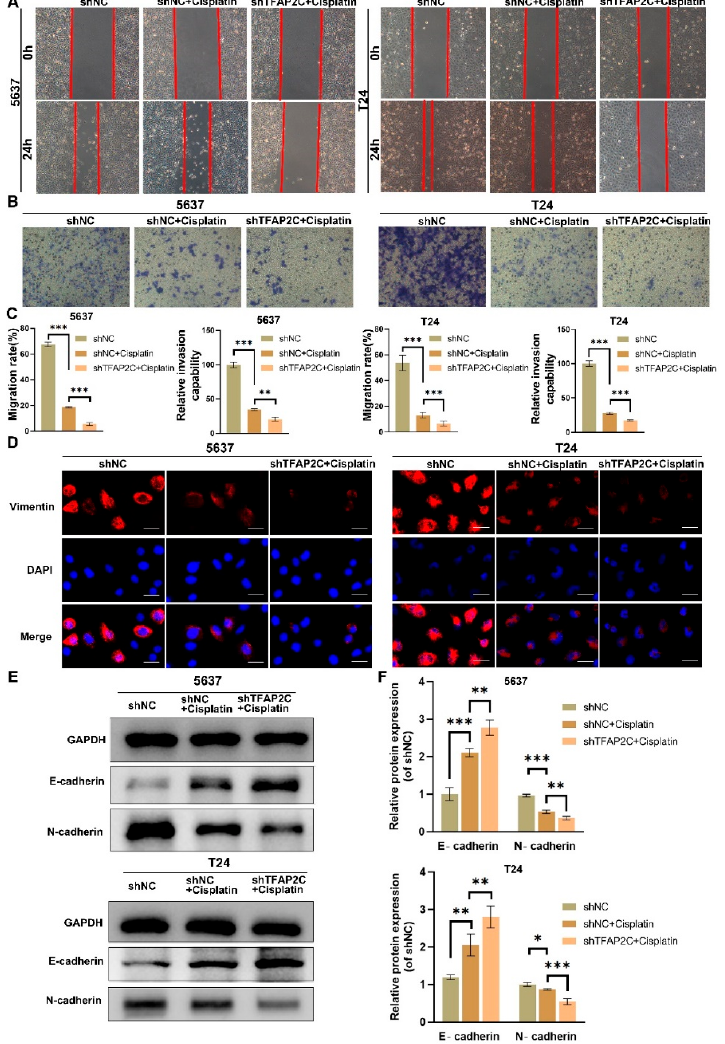
Figure 3. TFAP2C knockdown enhances the inhibitory effect of cisplatin on migration and invasion. ( A – C ) Representative images of the scratch assay in 5637 and T24 cells. Inhibition of migration by cisplatin is enhanced by TFAP2C knockdown. Representative images of the transwell assay. Inhibition of invasion by cisplatin is enhanced by TFAP2C knockdown ( D ) Representative images of vimentin immunostaining. Scale bars, 20 µ m. ( E , F ) Protein expression levels of E-cadherin and N-cadherin. Data represent the mean ( ± standard deviation, SD) of three independent experiments (* p < 0.05, ** p < 0.01, *** p <